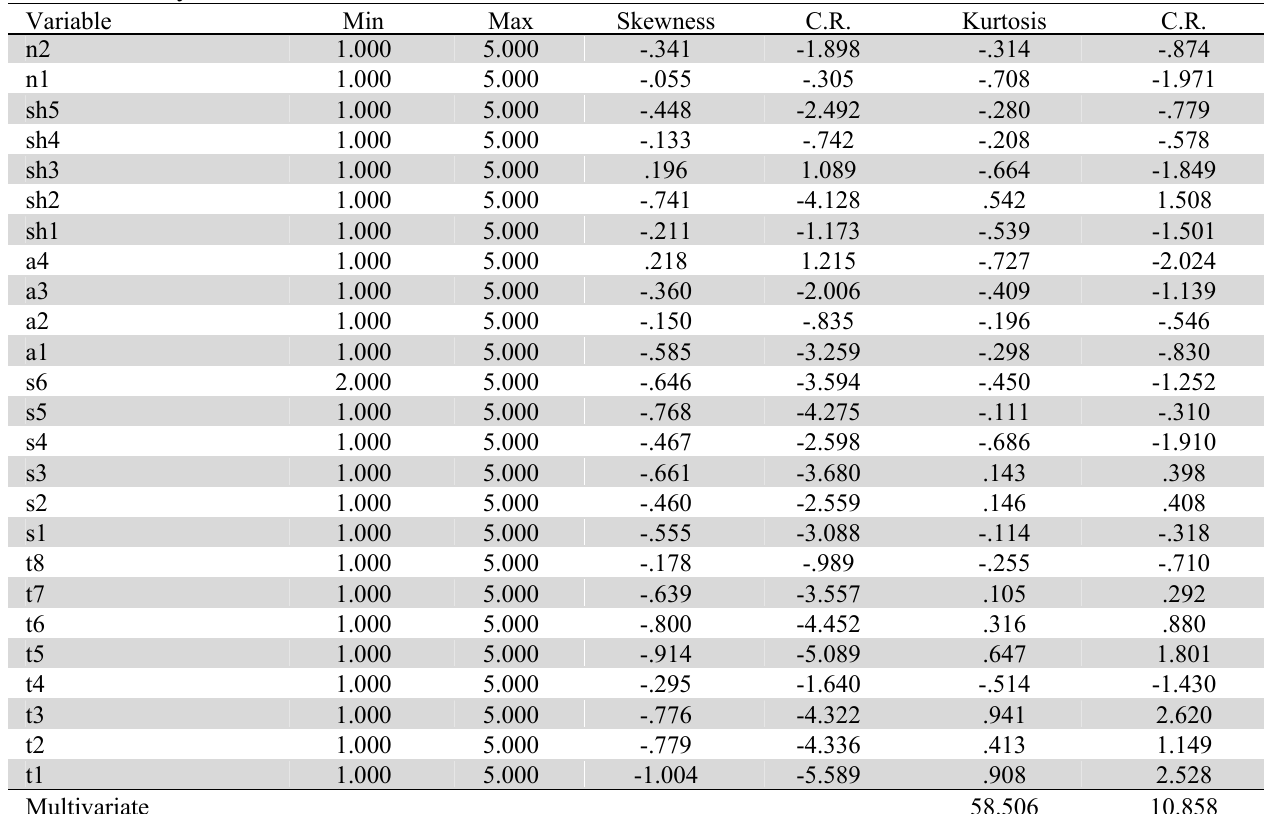
The summary of some basic